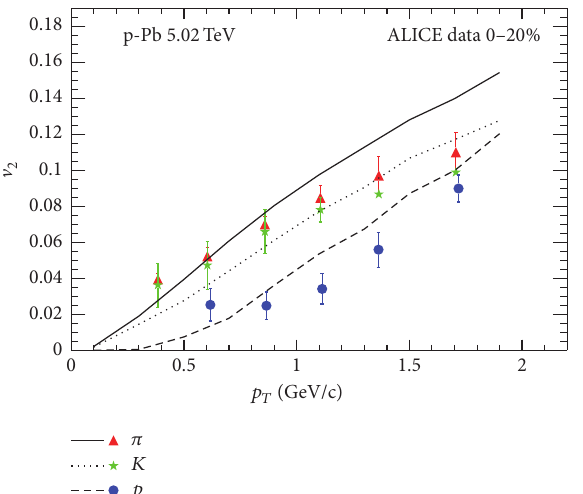
Figure 5: Elliptic flow, V 2 , of identified particles from the hydrodynamic model compared to the ALICE data [186]. The figure is taken from [187].